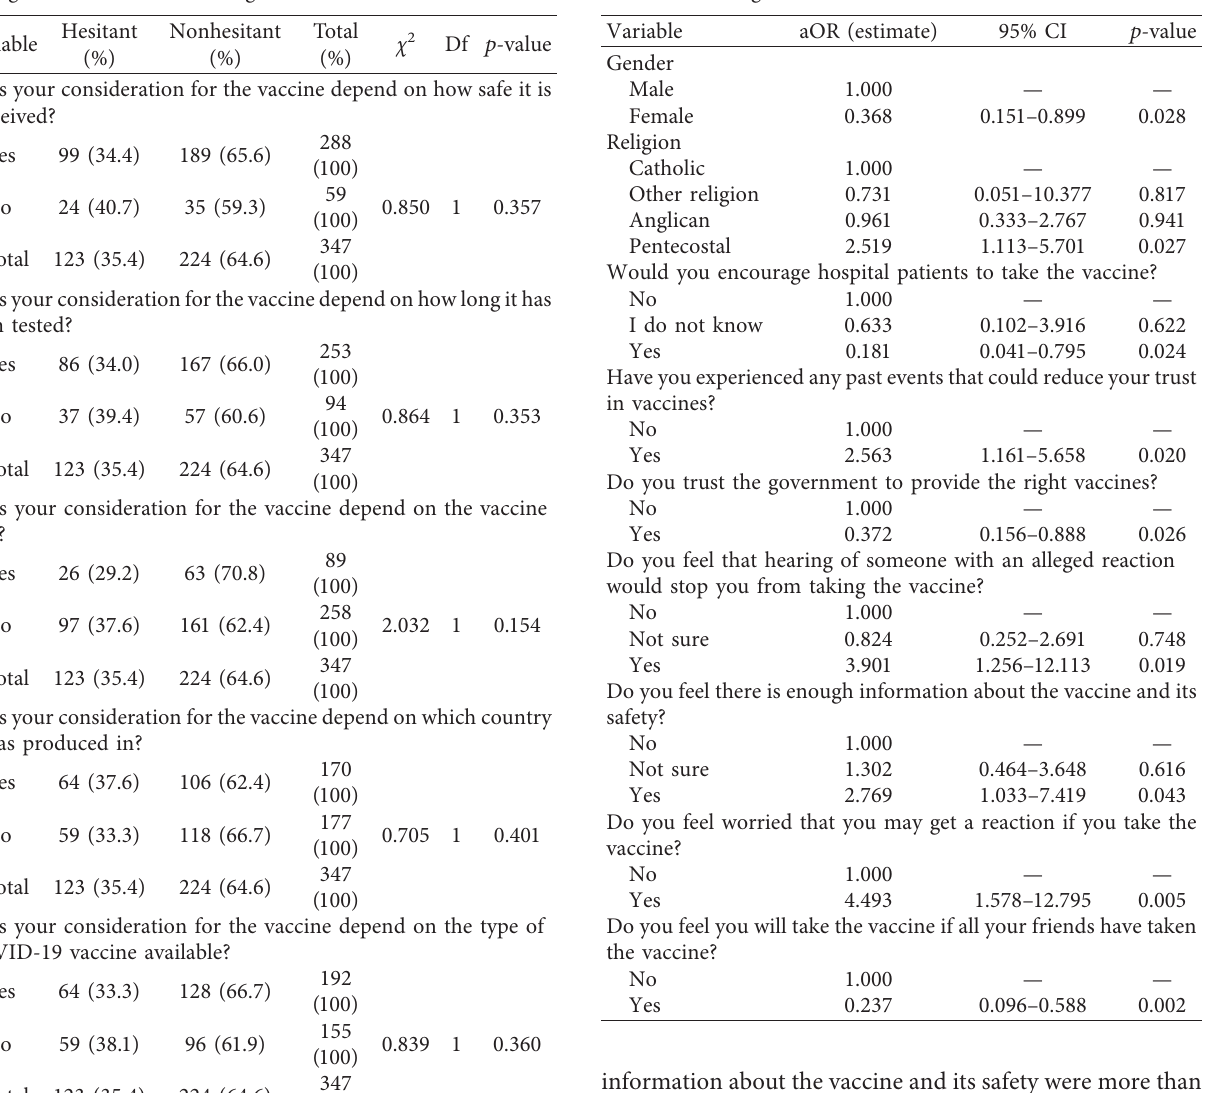
Table 6: Predictors of COVID-19 vaccine hesitancy among HCWs in Imo State,